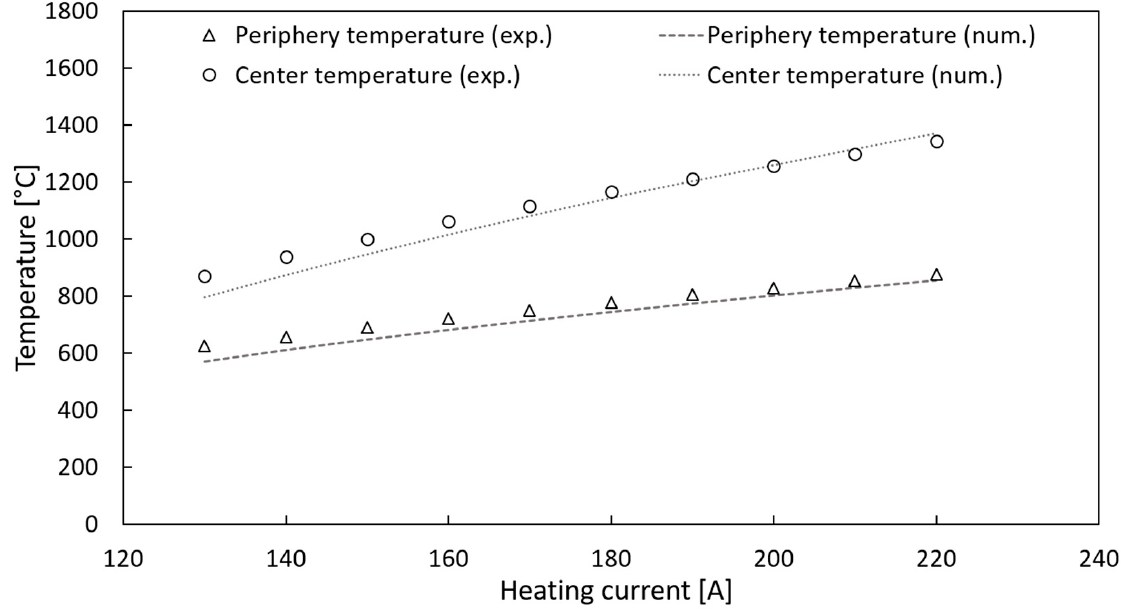
Figure 5. Comparison between the experimental and numerically calculated temperature values at the center and periphery of sample 1.